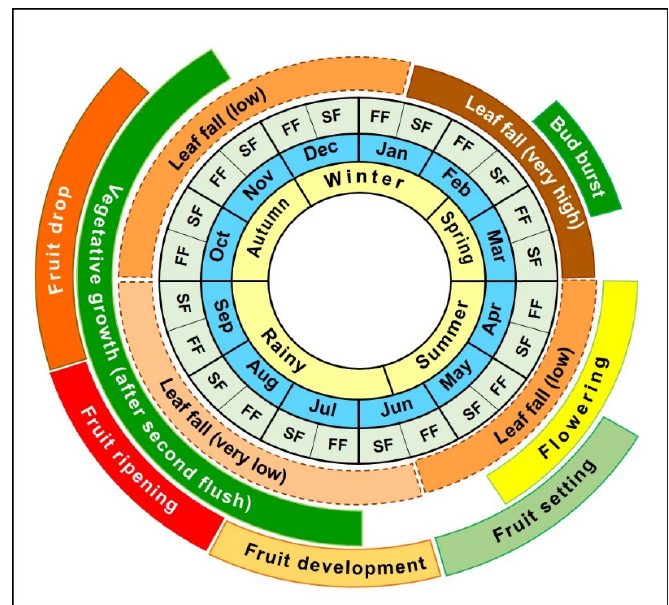
Figure 2. Graphical representation of phenological events in Pyracantha crenulata during different seasons, months and fortnights. FF – first fortnight; SF – second fortnight